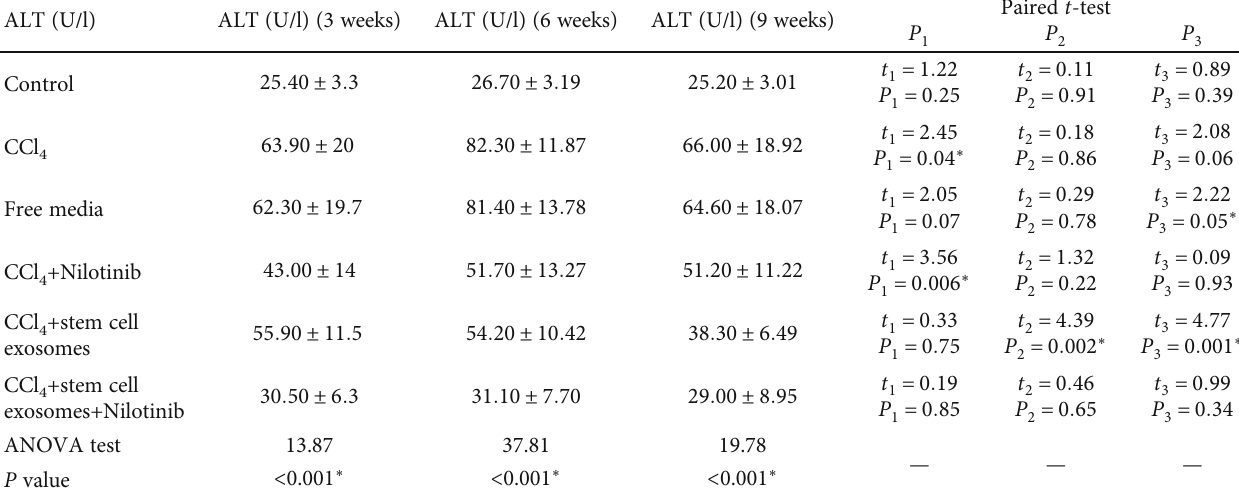
Table 1: ALT ± SD (U/l) among the studied groups after 3 weeks, 6 weeks, and 9 weeks. ALT (U/l) ALT (U/l) (3 weeks) ALT (U/l) (6 weeks) ALT (U/l) (9